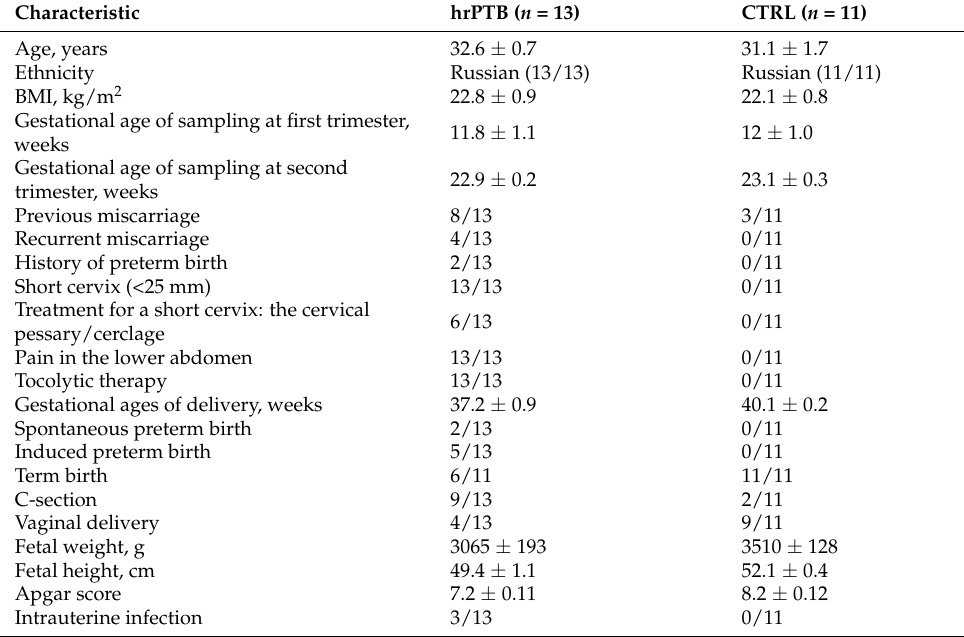
Table 1. Characteristics summary of the pregnant women included in the